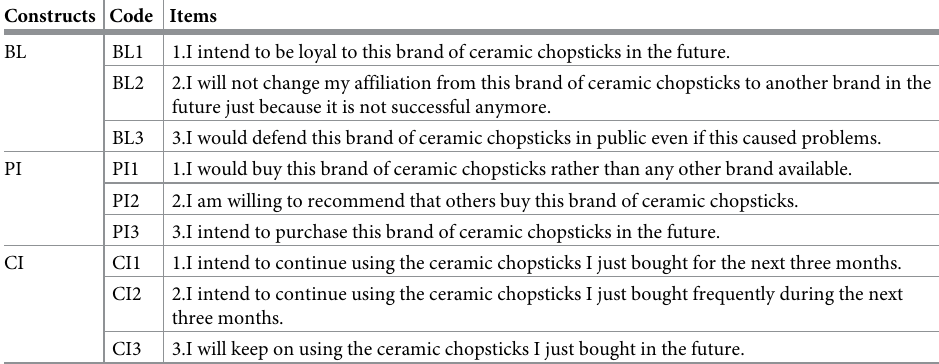
Table 3. Retail ceramic chopstick consumer behaviour